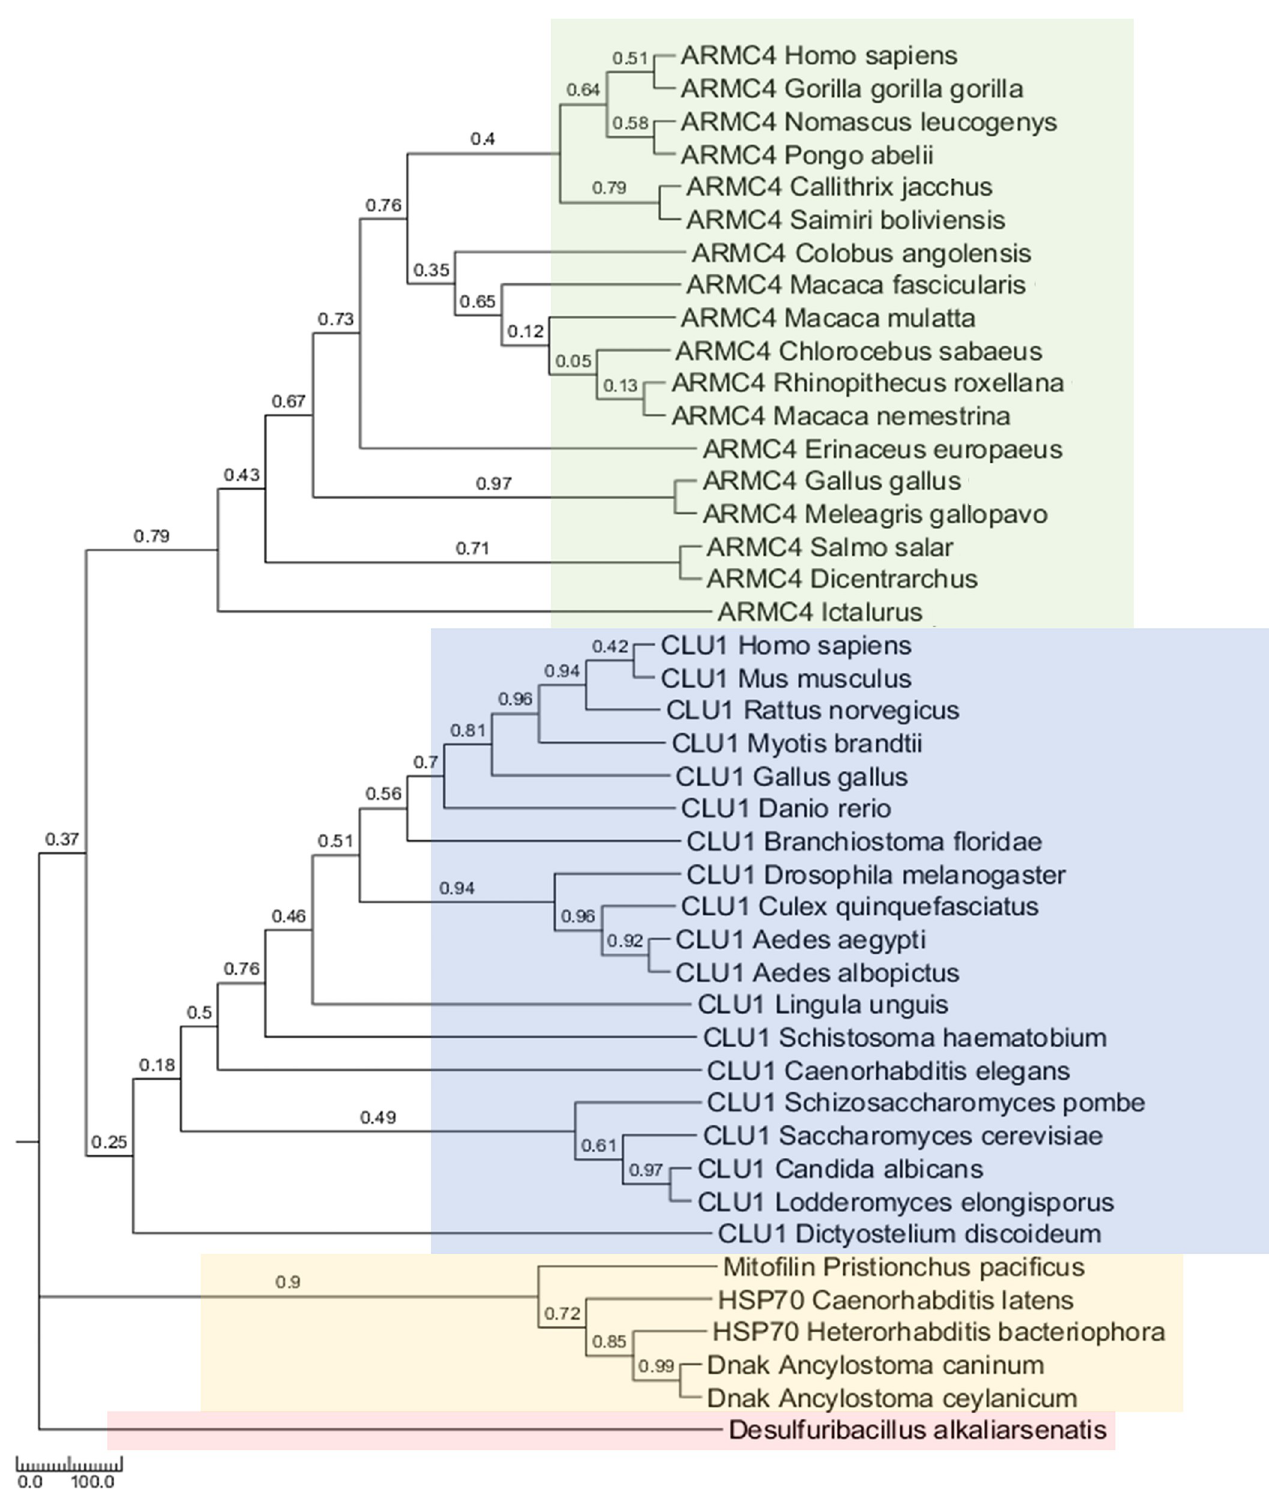
Fig 2. Phylogenetic analysis of four composite-type GSKIP proteins, namely ARMC4, CLU1, HSP70/Dnak and Mitofilin, among various species. The evolutionary history of GSKIP was inferred using the maximum likelihood method. Initial trees for the heuristic search were obtained automatically by applying the neighbor-joining and BioNJ algorithms to a matrix of pairwise distances estimated using the JTT model and by then selecting the topology with the superior log likelihood value. The tree is drawn to scale, with branch lengths measured in the number of substitutions per site. This analysis involved 43